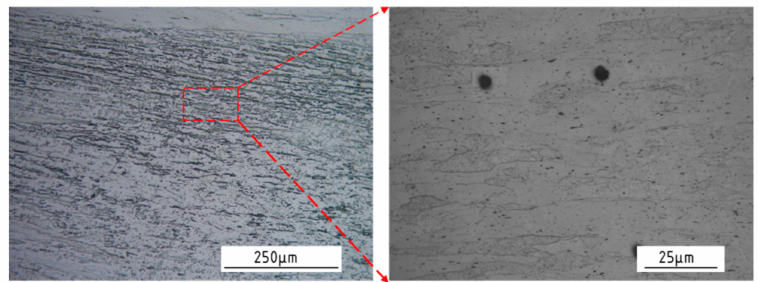
Figure 1. Cross-sectional microstructure of the hot-rolled powder metallurgy nanostructured molybdenum (NS Mo) alloy.